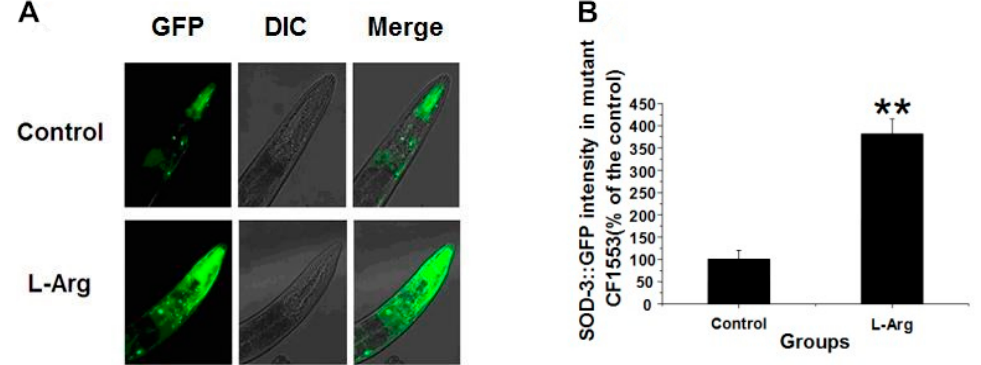
Figure 2. L -Arg upregulates SOD-3::GFP in CF1553 worms. ( A ) Images of SOD-3::GFP expression in L -Arg-treated and control worms; ( B ) Quantitative fluorescence analysis in transgenic CF1553 worms. The data are presented as the mean ± SE of four individual experiments, with 40 worms in each group (** p < 0.01).